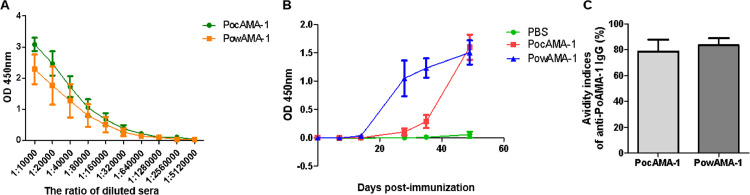
Anti-rPoAMA-1 IgG antibody responses and persistence. (A) Mouse serum IgG titers against rPoAMA-1. Sera obtained from immunized mice were diluted from 1:10,000 to 1:5,120,000, and the data were presented as the mean OD. (B) Days of post immune responses in rPoAMA-1-immunized mice. (C) Avidity indices of anti-PoAMA1 IgG. Significant differences between groups are denoted on the graph: * P < 0.05, **P < 0.01, *** P <0.001. Nonsignificant (ns) differences are indicated (P > 0.05).